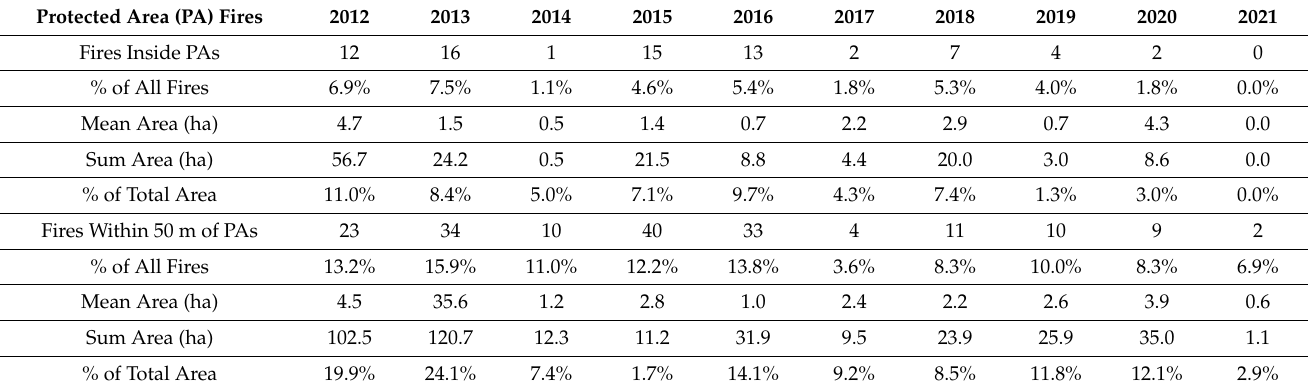
Table 4. Number of wildfires, mean number per year, burned area (ha), and mean area burned